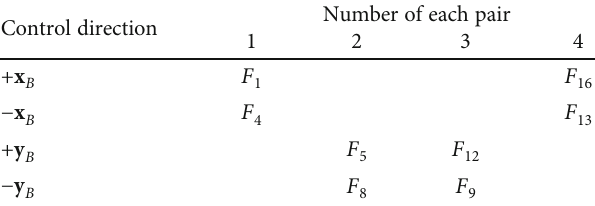
Table 2: Thruster distribution.